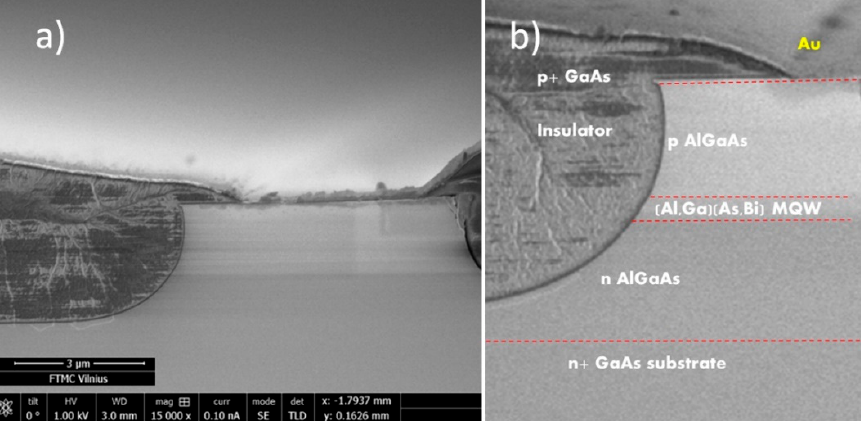
Figure 2. SEM picture of the view of the as-cleaved 5 μ m width LD bar after UV lithography and metallization ( a ) and a zoom-in image ( b ) with red dashed lines indicating the details of the textured structure as a visual guide.